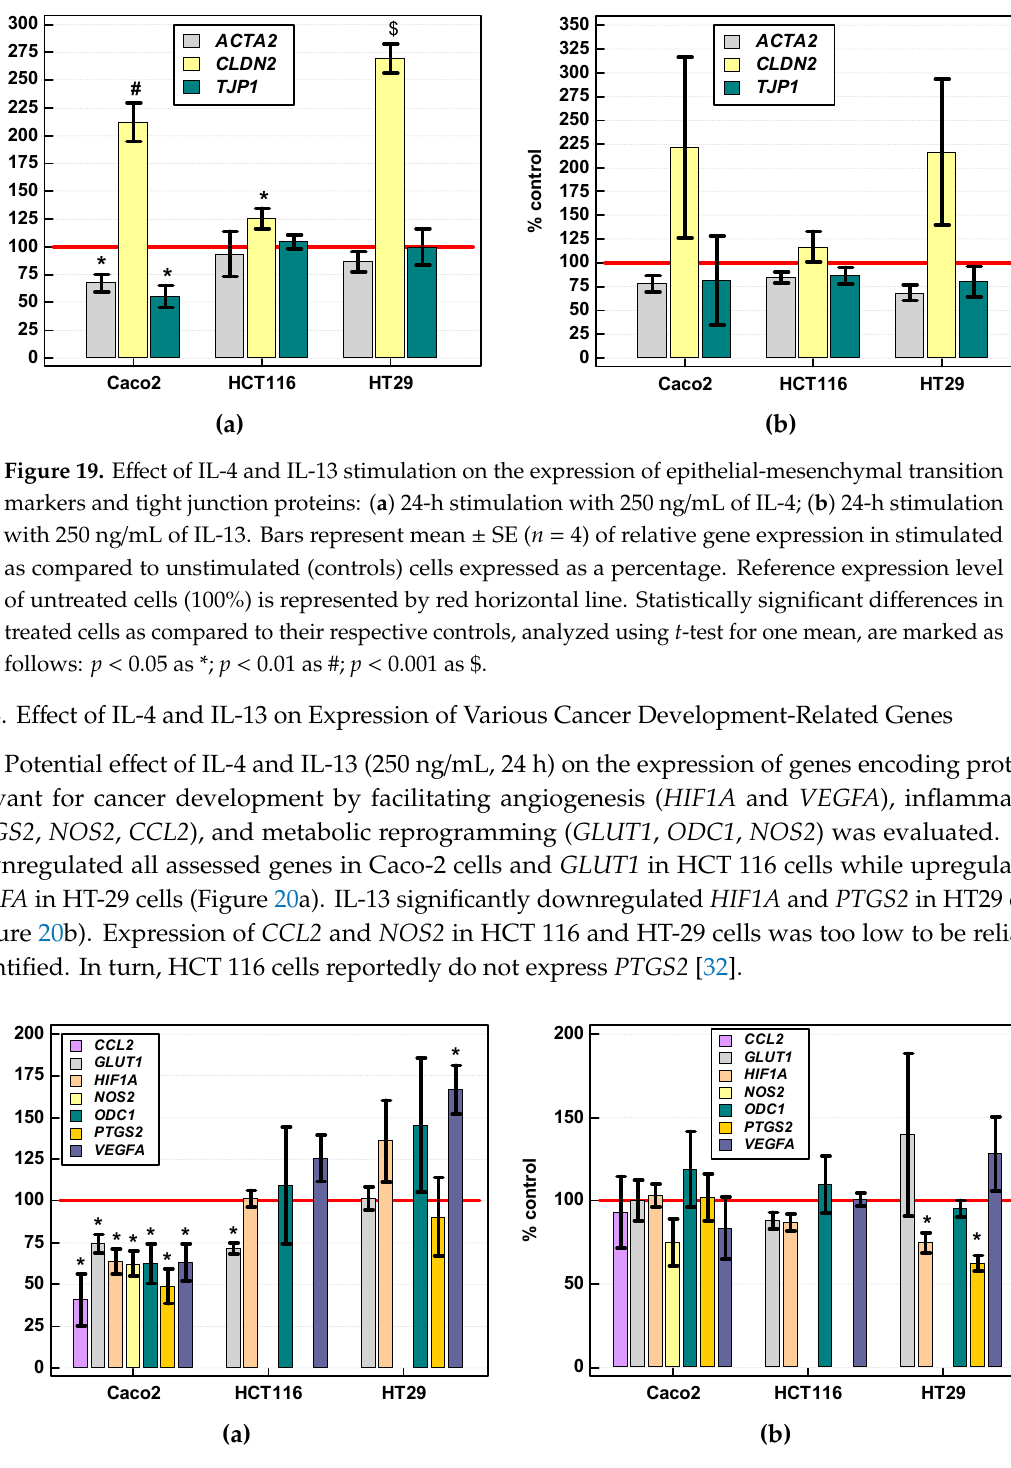
Figure 20. E ff ect of IL-4 and IL-13 stimulation on expression of various proteins relevant for cancer growth: ( a ) 24-h stimulation with 250 ng / mL of IL-4; ( b ) 24-h stimulation with 250 ng / mL of IL-13. Bars represent mean ± SE ( n = 4) of relative gene expression in stimulated as compared to unstimulated (controls) cells expressed as a percentage. Reference expression level of untreated cells (100%) is represented by horizontal red line. Statistically significant di ff erences ( p < 0.05) in treated cells as compared to their respective controls, analyzed using t -test for one mean, are marked with asterisks